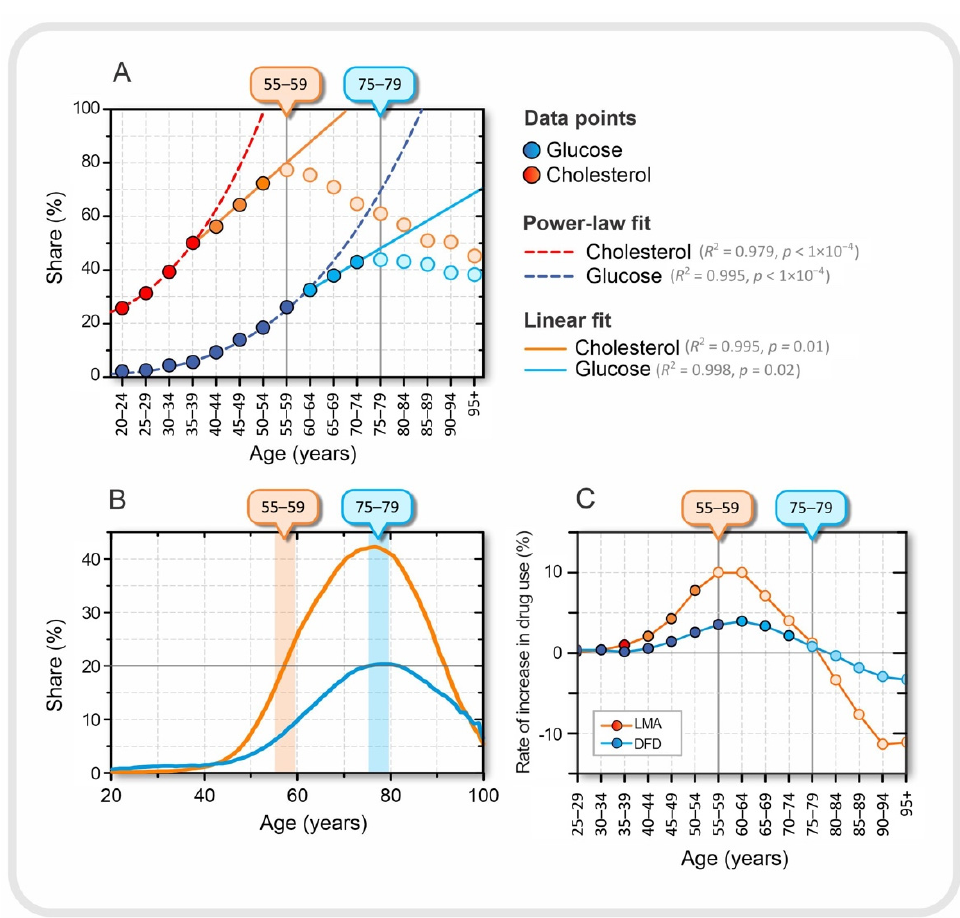
Figure 4. Relationship between laboratory results and drug use. ( A ) Proportion of patients in a given age group with either elevated serum lipids (orange) or elevated serum glucose (blue), approximated with best fit, a power-law fit up to ages 35–39 for cholesterol and 55–59 for glucose. A good linear fit is observed in the age groups between 40–44 and 50–54 for cholesterol and between 60–64 and 70–74 for glucose. The dark orange and dark blue dots were used for the power-law fit, the orange and blue dots for the linear fit, and the light blue and light orange dots represent the decreasing trend of the proportions in the last tercile. The age at which the proportion of patients with elevated serum lipid and serum glucose levels peaks is indicated by the orange and blue boxes on the upper horizontal axes, respectively. ( B ) Proportion of patients of a given age taking lipid-modifying agents, LMA (orange) and drugs for diabetes, DFD, (blue). ( C ) Rate of increase in the proportion of patients between the two consecutive age groups taking a particular type of medication.